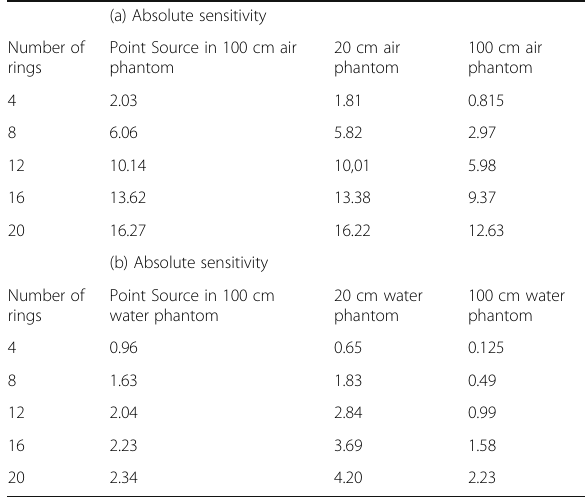
Table 1 (abstract A22). Absolute sensitivity for point source, short phantom and long phantom in (a) air and (b) water (a) Absolute sensitivity